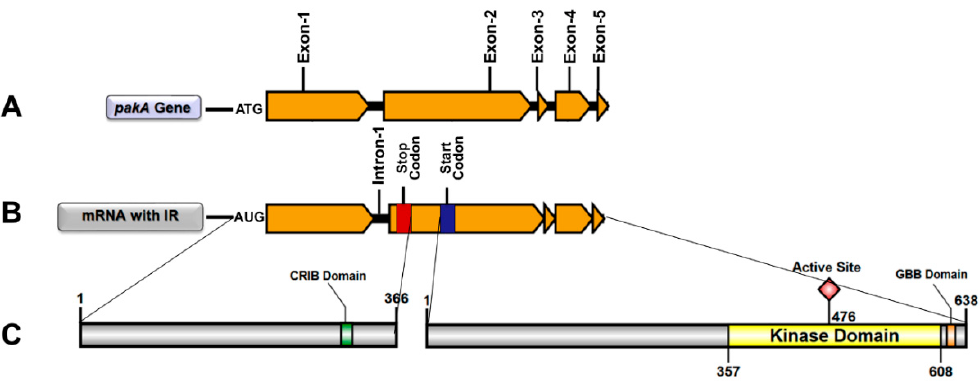
Figure 3. Graphical representation of alternative pakA / Ste20 gene transcription/splicing/translation in T. rubrum . ( A ) Graphical representation of the pakA / Ste20 kinase gene with its five exons (dark yellow) and four introns (black); ( B ) Graphical representation of mRNA transcribed from the pakA / Ste20 kinase gene with retention of intron 1; ( C ) Graphical representation of both probable functional STE20/PAKA proteins, with their respective domains, translated from intron-retained mRNA.